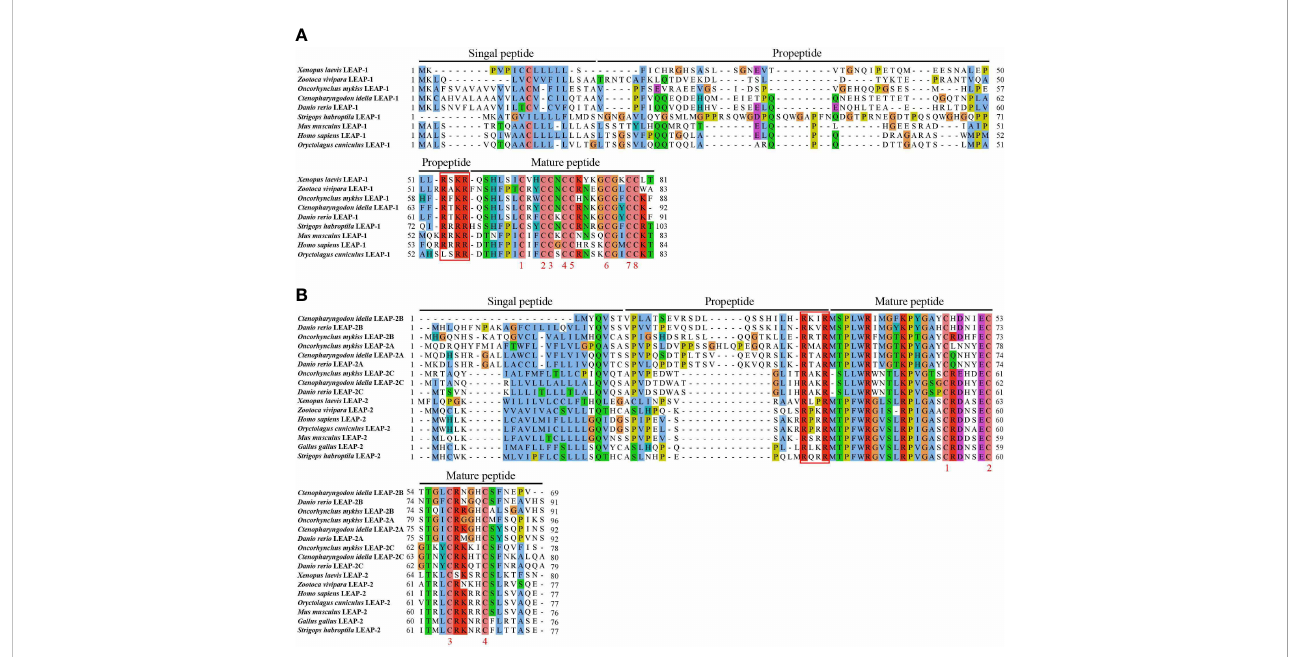
FIGURE 1 Amino acid sequence and domain organization of LEAP-1 (A) and LEAP-2 (B) from mammals, birds, amphibians, reptiles, and fi sh. The signal peptide, propeptide and mature peptide are denoted above the alignment. GenBank accession numbers of the selected sequences are listed in Table